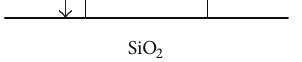
, 𝑛 , 𝑛 , 𝛽 2 , and si effTE effTM TE